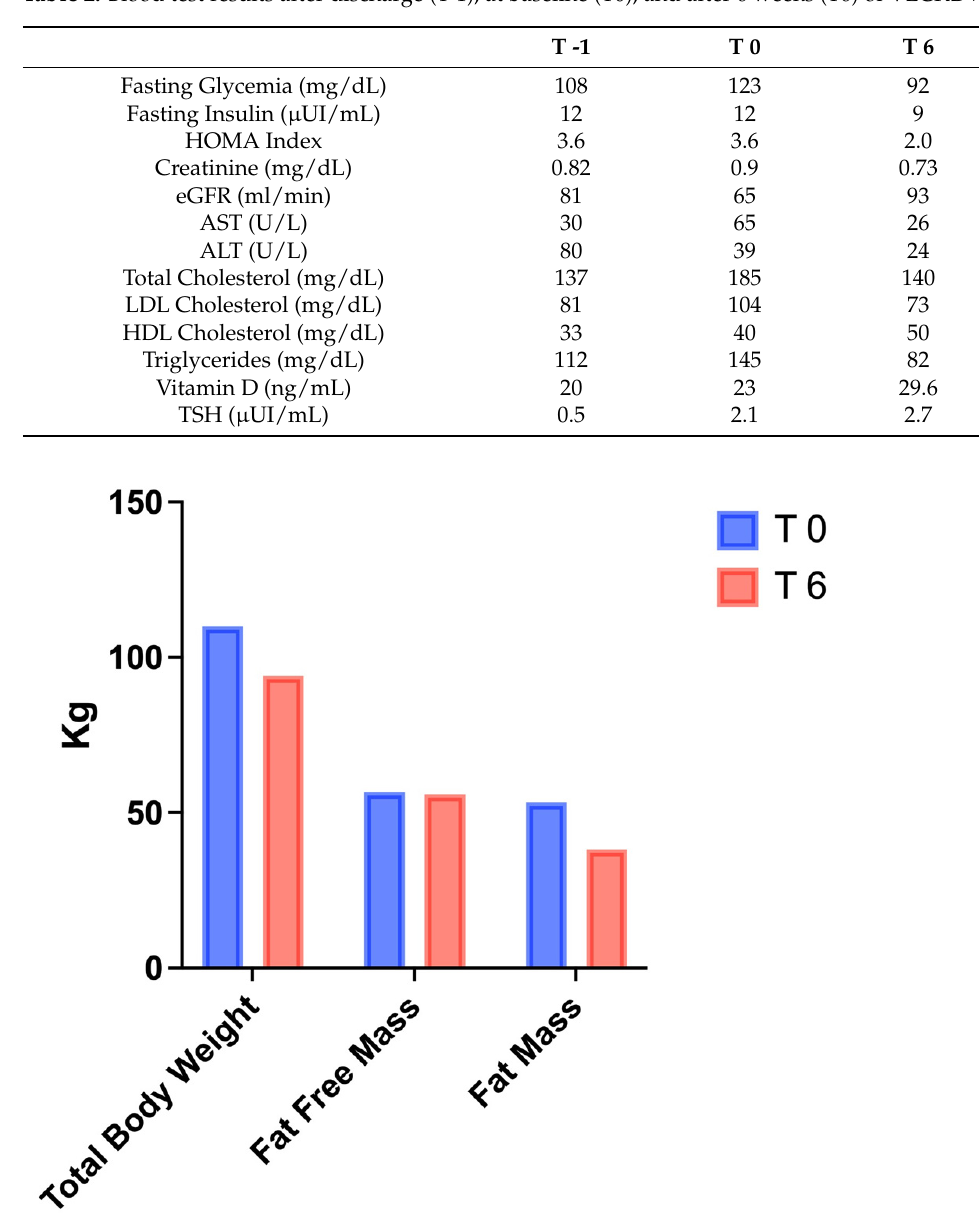
Table 2. Blood test results after discharge (T-1), at baseline (T0), and after 6 weeks (T6) of VLCKD+IT.